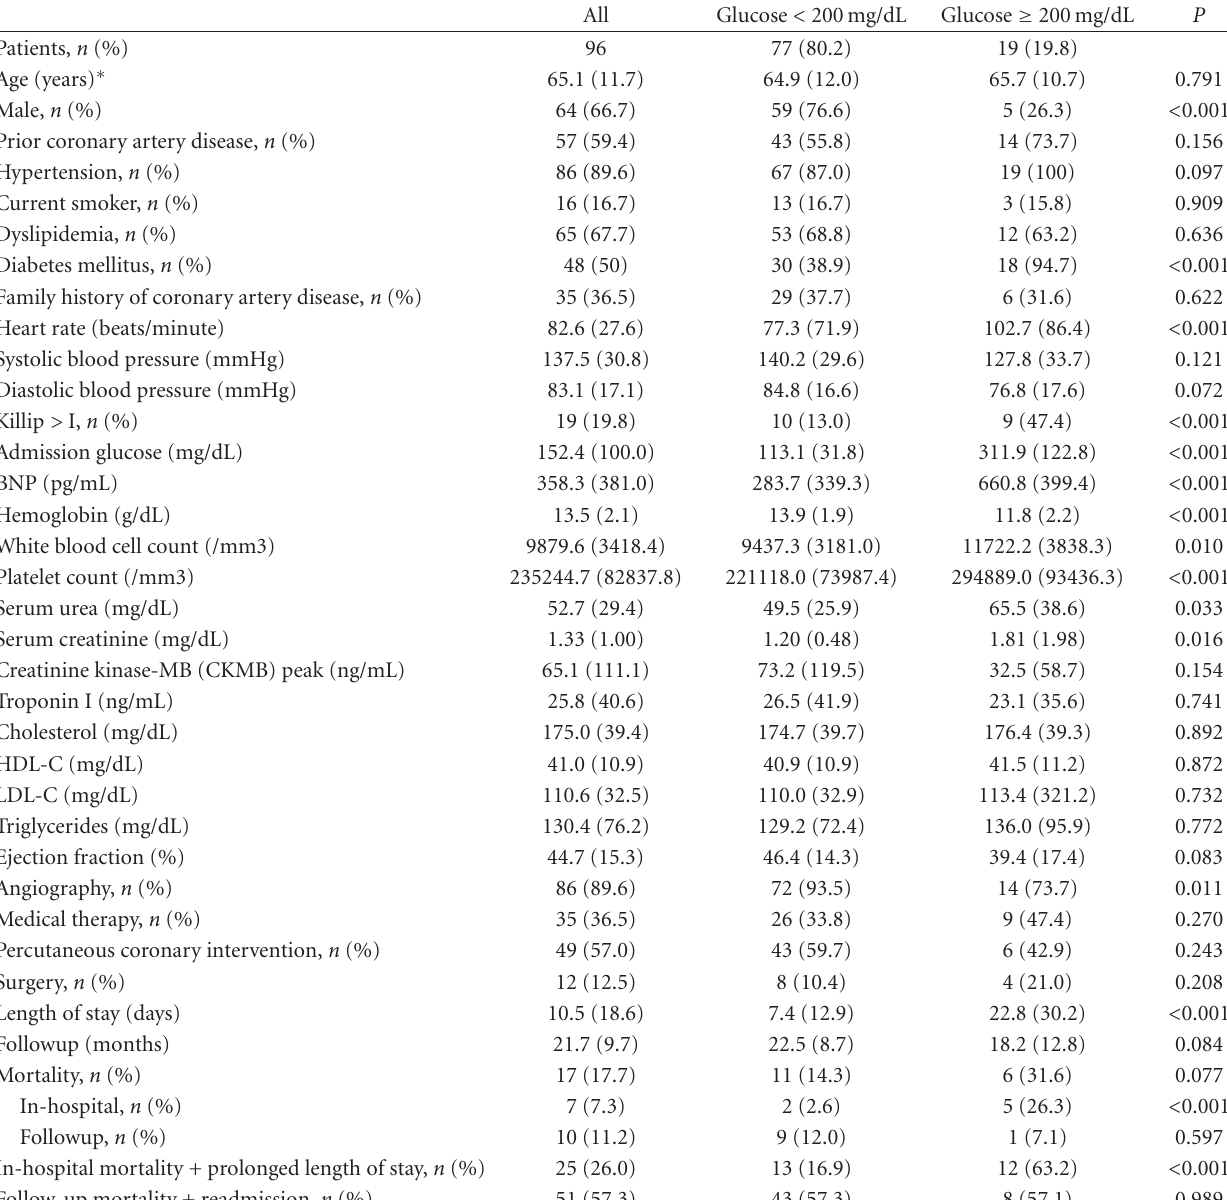
Table 1: Clinical and demographic patient characteristics, grouped by blood glucose ≥ or <